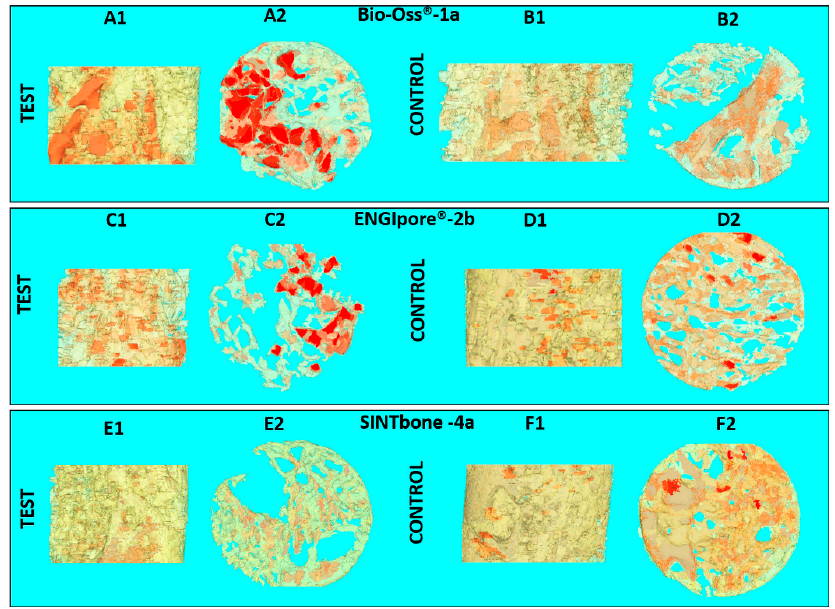
Figure 5. Clinical phase—Part 2, micro-CT reconstructed images for specimens test (left side) and control site (right side): ( A1 ) 1a test, section of the entire specimen; ( A2 ) 1a test, selected slice; ( B1 ) 1a control, section of the entire specimen; ( B2 ) 1a control, selected slice; ( C1 ) 2b test, section of the entire specimen; ( C2 ) 2b test, selected slice; ( D1 ) 2b control, section of the entire specimen; ( D2 ) 2b control, selected slice; ( E1 ) 4a test, section of the entire specimen; ( E2 ) 4a test, selected slice; ( F1 ) 4a control, section of the entire specimen and ( F2 ) 4a control, selected